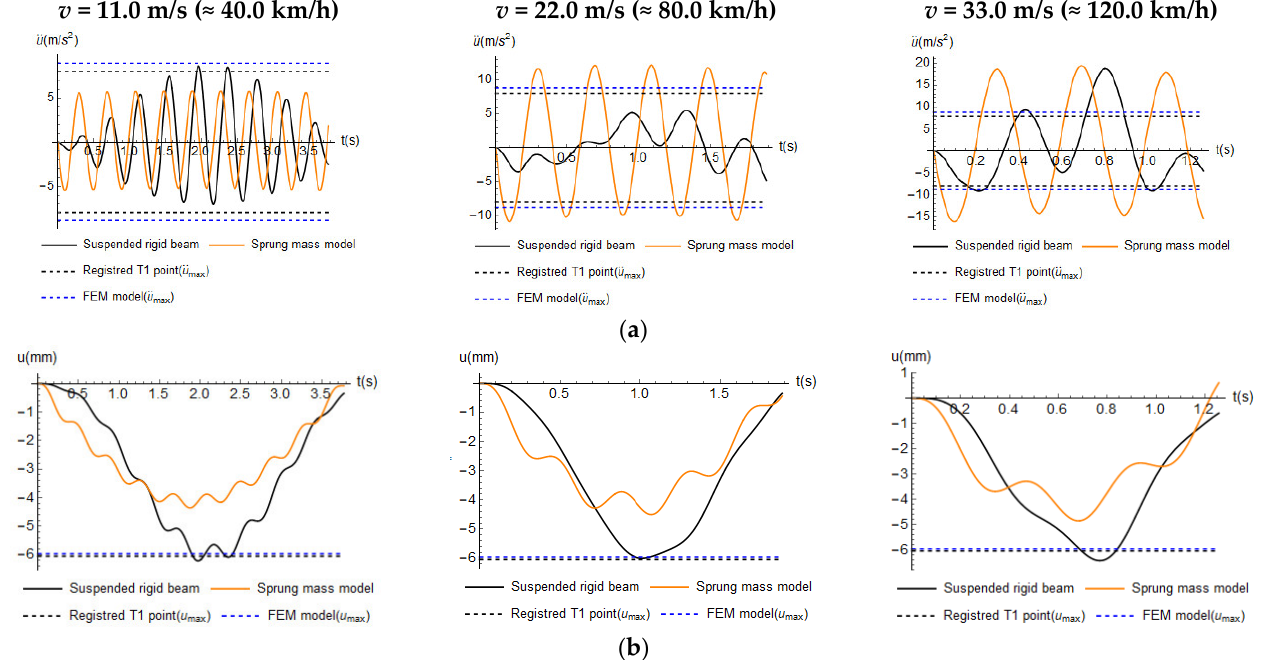
Figure 12. Dynamic bridge response in terms of vertical ( a ) accelerations and ( b ) displacement for some v .